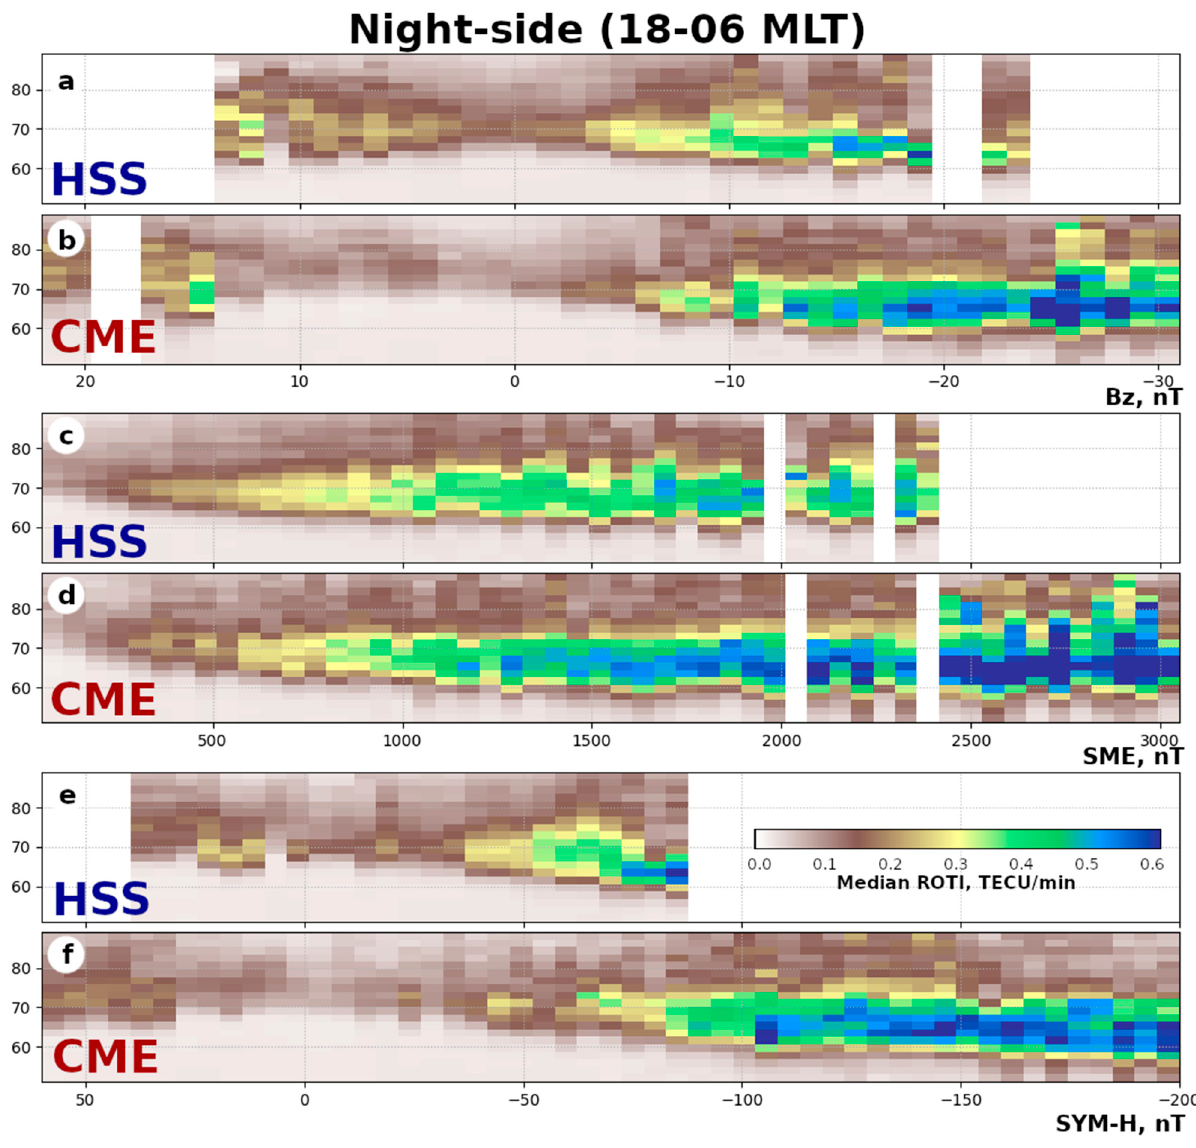
Figure 16. Median ROTI versus magnetic latitude MLAT and IMF Bz (a, b), SME (c, d), and SYM-H indices (e, f) during magnetic local night (18–6 MLT) of HSS- and CME-driven storms. Similarly, the combined median ROTI distributions for the nighttime (18–6 MLT) are shown in Figure 16. Unlike the dayside, the initial (quiet conditions) location of the boundaries is about 70 ◦ MLAT. With the development of a storm, both the boundaries shift in opposite directions (Figure 16c,d): the equatorial boundary equatorward and the polar one poleward. For both types of storms, the oval widens with an SME increment. During a CME-driven storm, the nighttime median ROTI shows higher values with the same index values, and, at the high values of SME (>2400 nT), the polar boundary exceeds 80 ◦ MLAT. The width increment of the ROTI oval agrees with the location of the auroras [52]: the equatorial boundary of the aurora shifts equatorward with an increase in magnetic activity, while their polar boundary shifts equatorward at dayside and poleward at nightside. At the same time, the polar boundary of the ROTI oval at dayside shifts pole- ward. So, during strong storms (SME > 2500 nT), the ROTI seems to be intensified not only at the oval boundary but also in the polar cap as well.